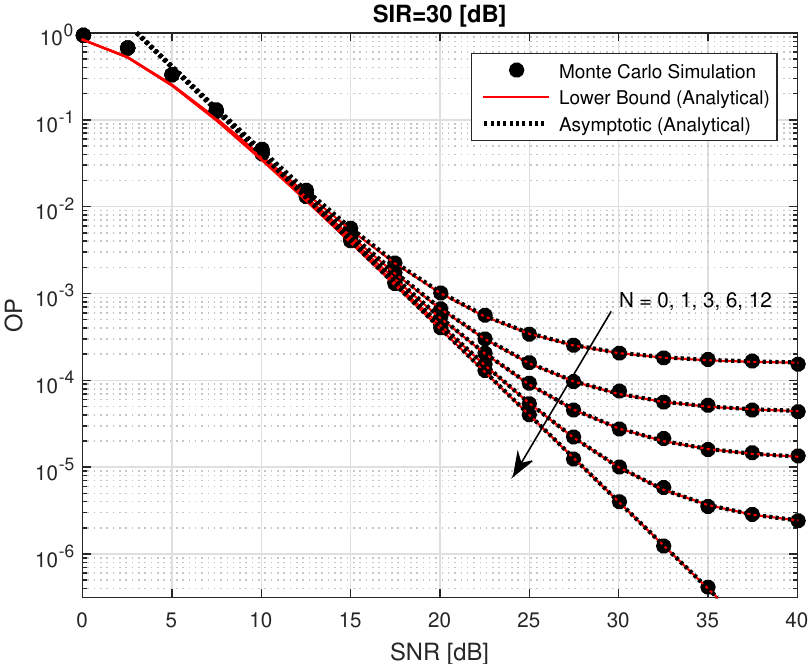
Figure 4. System outage probability of AF-TWRN with different numbers of co-channel interference signals, γ th = 0 dB and L 1 = L 2 = 2.